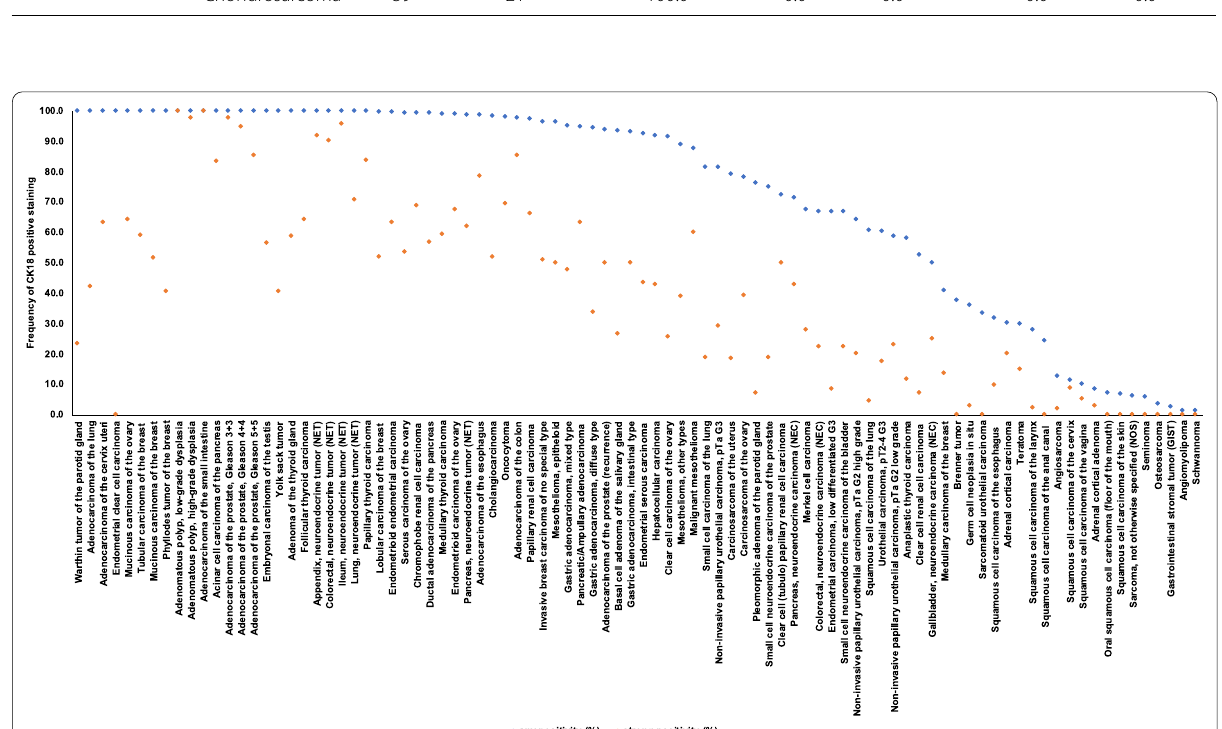
Fig. 3 Ranking order of Cytokeratin 18 (CK18) immunostaining in cancers. Both the frequency of positive cases (blue dots) and the frequency of strongly positive cases (orange dots) are shown. The conspicuously low rate of strongly positive Whartin tumors is due to the fact, that only basal cells react with CK18 resulting in a low overall percentage of positive cells. 25 additional tumor entities without any CK18 positive cases are not shown due to space